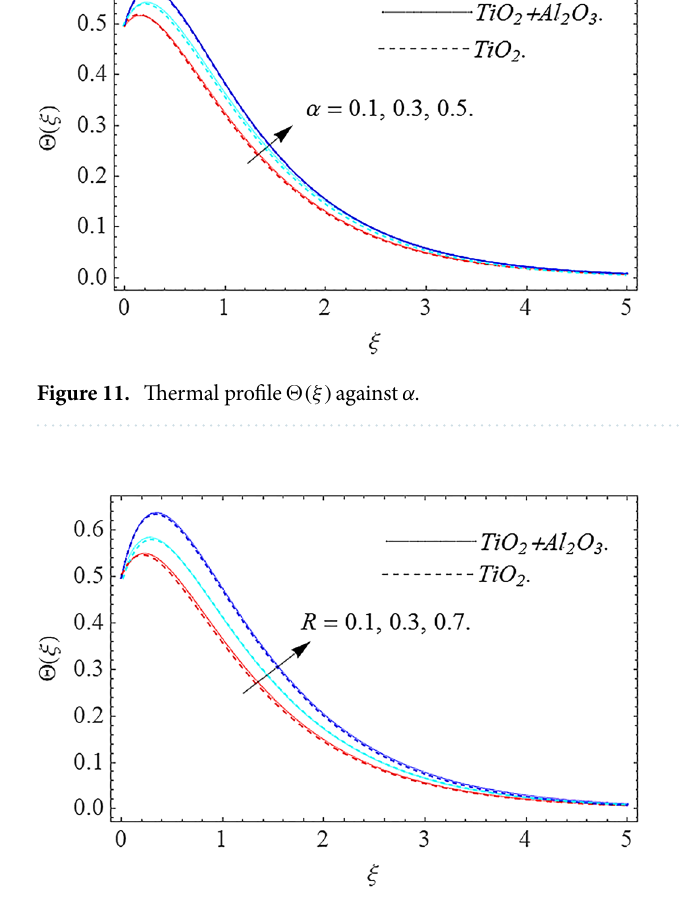
Figure 12. Thermal profile �(ξ) against R